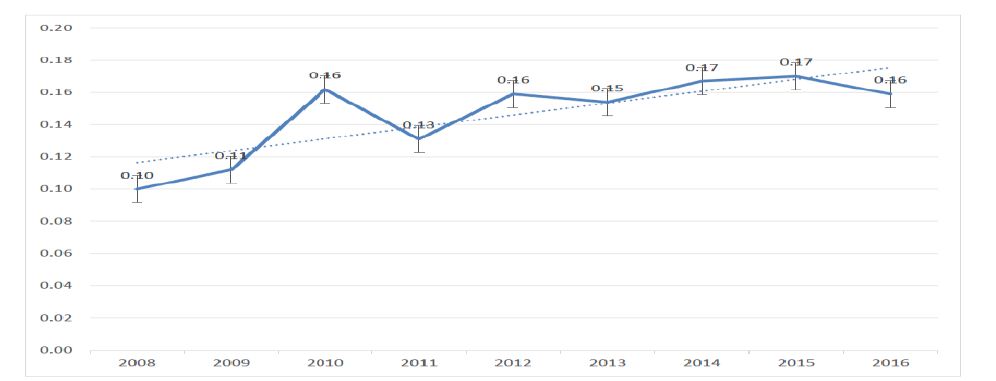
Fig. 2: Trend of performance of Kenya’s listed commercial banks; Source: Omwando (2017).